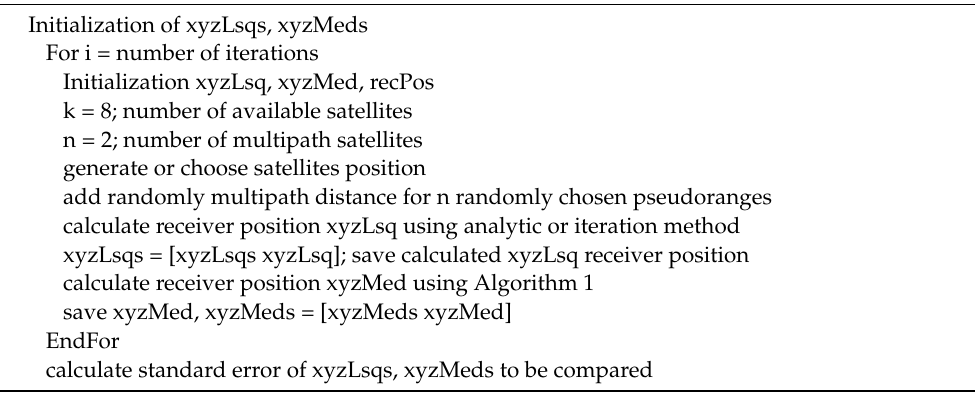
Algorithm 2: Algorithm Test Pseudocode